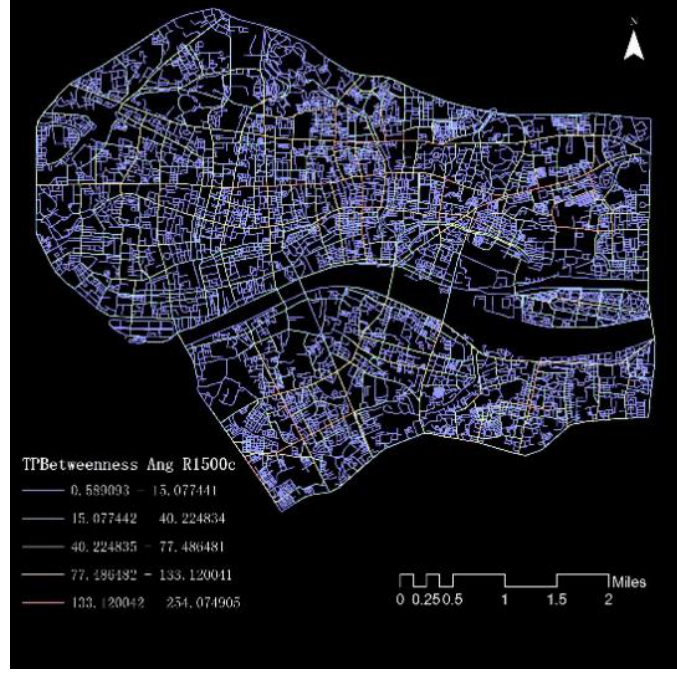
Fig. 16 Regional TPBt at a radius of